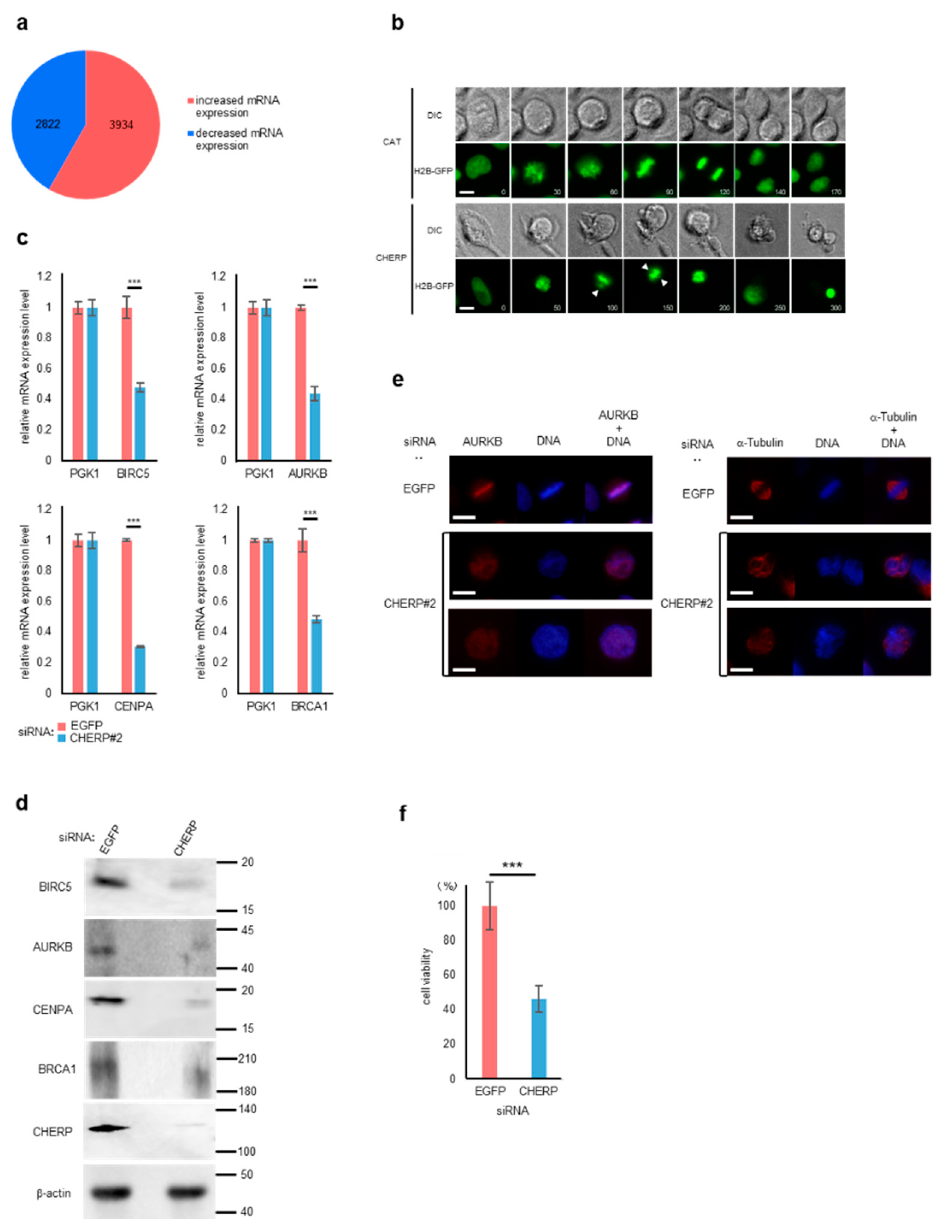
Figure 6. CHERP is involved in cell survival and cell death through the expression of cell cycle regulators. ( a ) Number of increased and decreased mRNA expression events after CHERP deple- tion. Events with FDR < 0.05 were considered statistically significant. ( b ) Live-cell imaging pictures of chloramphenicol acetyltransferase (CAT: control) and CHERP-depleted (CHERP#2) U2OS cells stably expressing histone 2B-green fluorescent proteins (H2B-GFP). The numbers at the bottom right side of the pictures indicates the time (min) from nuclear envelope breakdown (NEBD). The arrow- head indicates the misaligned chromosome. Scale bar, 10 µm. ( c ) Cytoplasmic expression of mRNAs under CHERP depletion. The mRNA expression of factors regulating the cell cycle (the Sur- vivin/baculoviral IAP repeat containing 5 [BIRC5]), cell division (aurora kinase B [AURKB] and cen- tromere protein A [CENPA]), and apoptosis (breast cancer type 1 [BRCA1]), was measured by re- verse transcription-quantitative PCR (RT-qPCR) and normalized to the levels of phosphoglycerate kinase 1 (PGK1) mRNA. The bars indicated relative mRNA expression of samples treated with siRNA against EGFP (red) and CHERP#2 (blue). Statistical analyses were performed using one-way analysis of variance (ANOVA) followed by Dunnett’s test. *** p < 0.001. ( d ) The cytoplasmic expres- sion of BIRC5, AURKB, CENPA and BRCA1 proteins after CHERP depletion, measured by Western blot. Protein levels were normalized to β -actin levels. ( e ) Effect of CHERP depletion on AURKB and